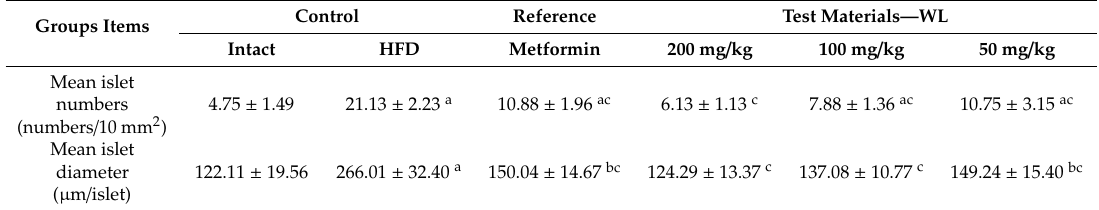
Table 7. Changes in pancreatic islet numbers and mean diameters in NFD or HFD supplied